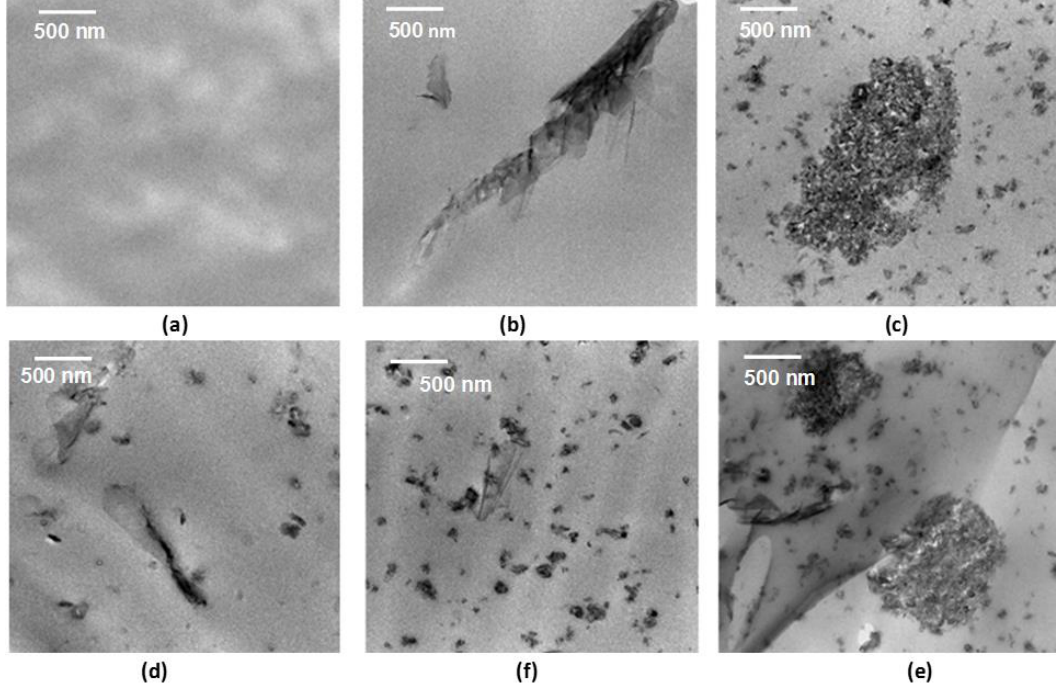
Figure 1. TEM micrographs of 6 wt.% monofiller and bifiller composite films, varying the types and the combinations of carbon fillers: ( a ) neat poly (lactic) acid (PLA); ( b ) 6 graphene nanoplatelets (GNP)/PLA; ( c ) 6 carbon nanotubes (CNT)/PLA; ( d ) 4.5GNP/1.5CNT/PLA; ( e ) 1.5GNP/4.5CNT/PLA; and ( f ) 3GNP/3CNT/PLA.